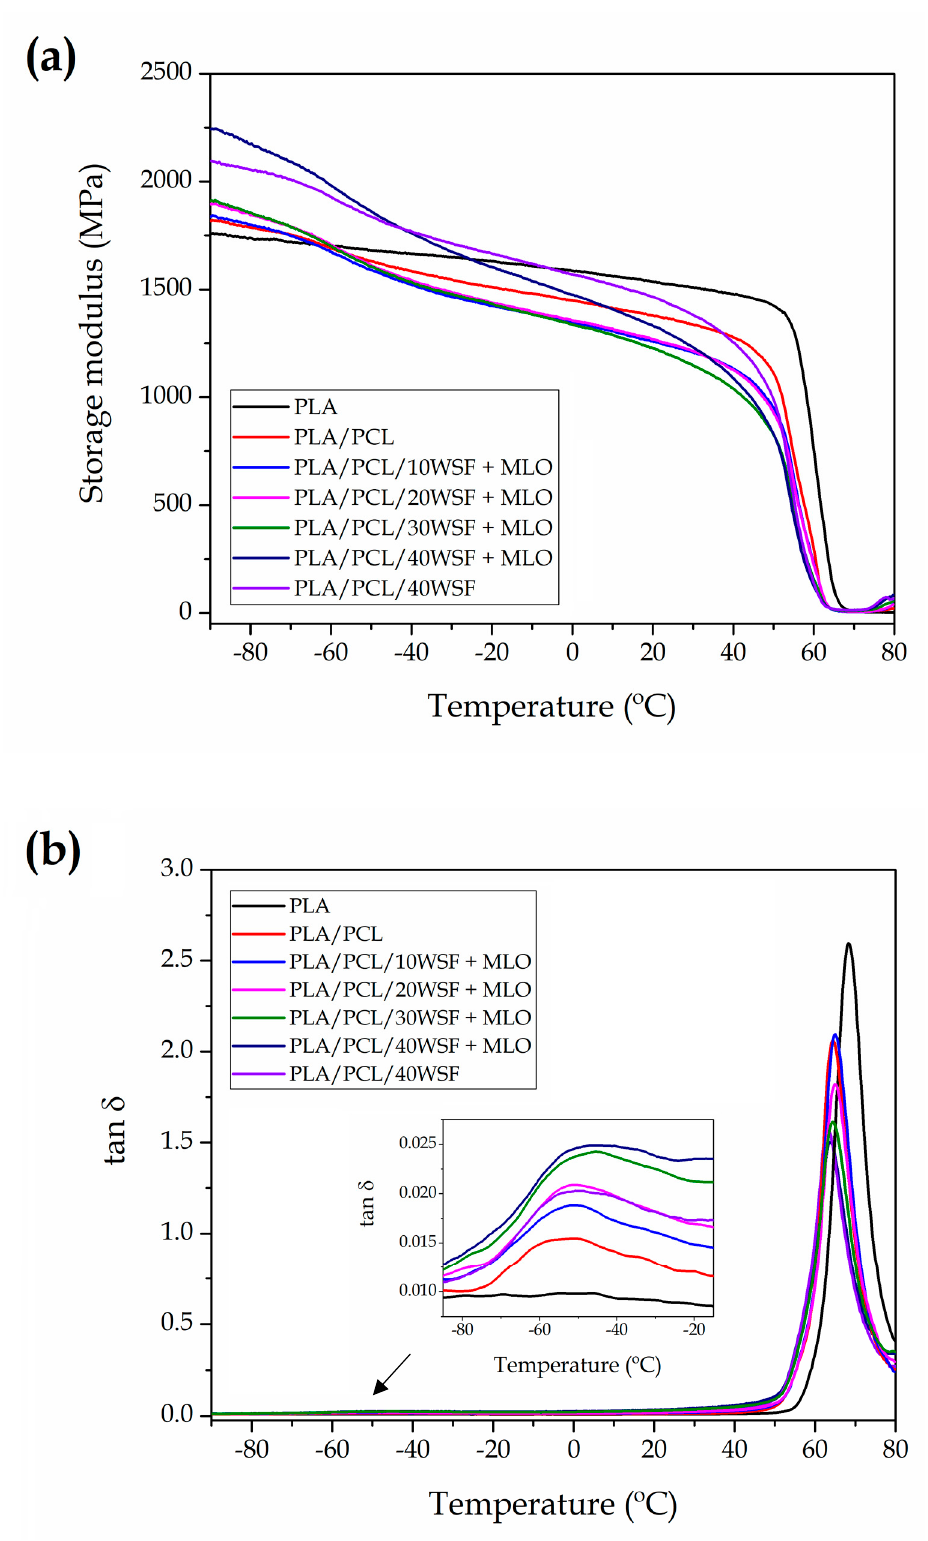
Figure 6. Evolution as a function of temperature of the ( a ) storage modulus (E’) and ( b ) dynamic damping factor (tan δ ) of the green composites made of polylactide (PLA), poly( ε -caprolactone) (PCL), walnut shell flour (WSF), and maleinized linseed oil (MLO).